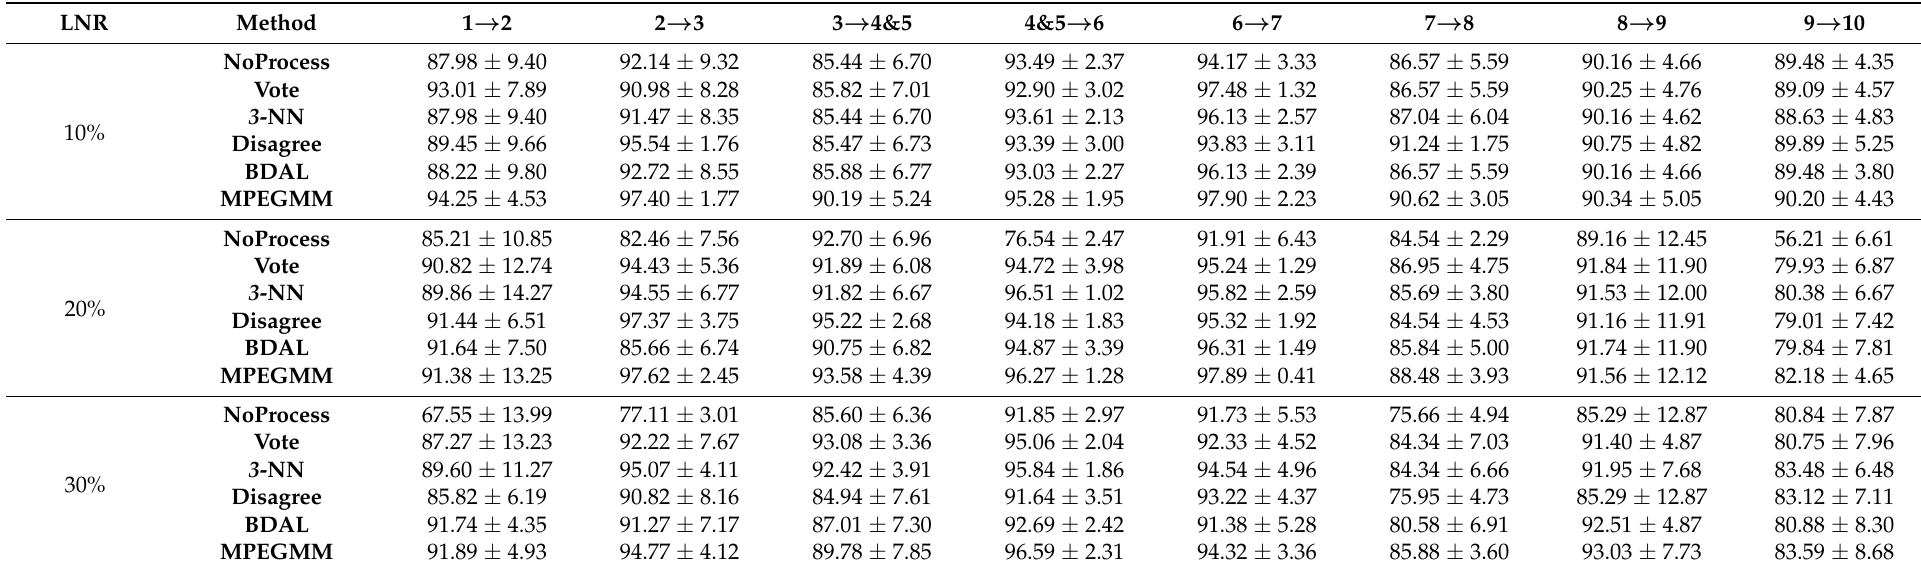
Table 4. Accuracy on dataset A under setting 2 (%).